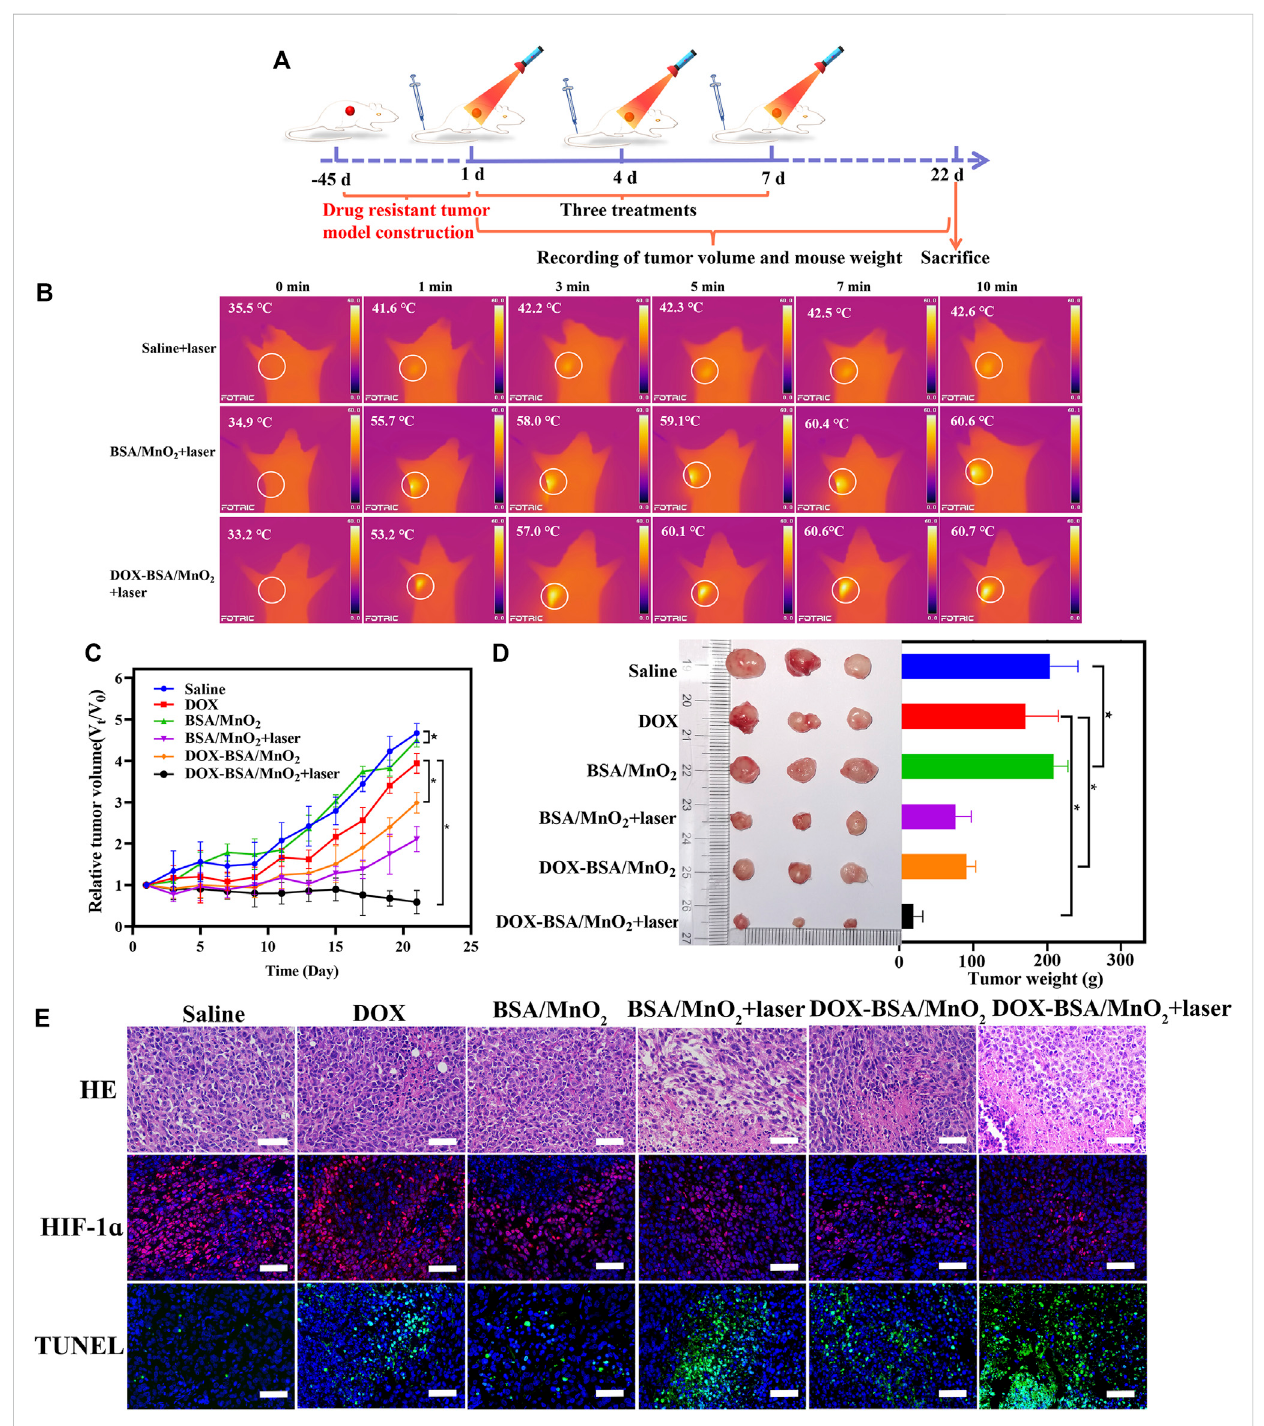
FIGURE 5 In vivo antitumor effectiveness of NPs on MCF-7/ADR bearing BALB/c nude mice. (A) Diagrammatic representation of the experimental animal design; (B) thermal in vivo photos and tumor temperature of mice under 635 nm laser irradiation (1.5 W/cm 2 , 10 min); (C) relative tumor volume change curvesofmicefollowingvarioustherapies;n=3; (D) visualobservationsoftumorsizesandweightsattheendtimepoint;n=3; (E) representativeimages of HE; TUNEL; and HIF-1 α staining of the tumor following various therapies on the 22nd day; nuclei in blue (DAPI staining); apoptotic cells in green (TUNEL staining); and hypoxic cells in red (HIF-1 α staining); scale bar = 50 μ